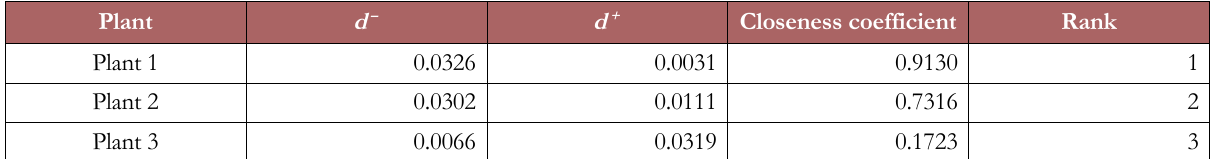
Table 10. Distance, closeness coefficient and the rank of each plant